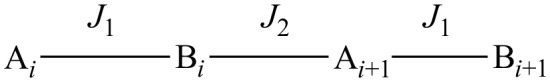
A representation of the exchange coupling constants (J1 and J2) of an alternating ferrimagnetic chain complex; A and B represent the two different spin carriers.